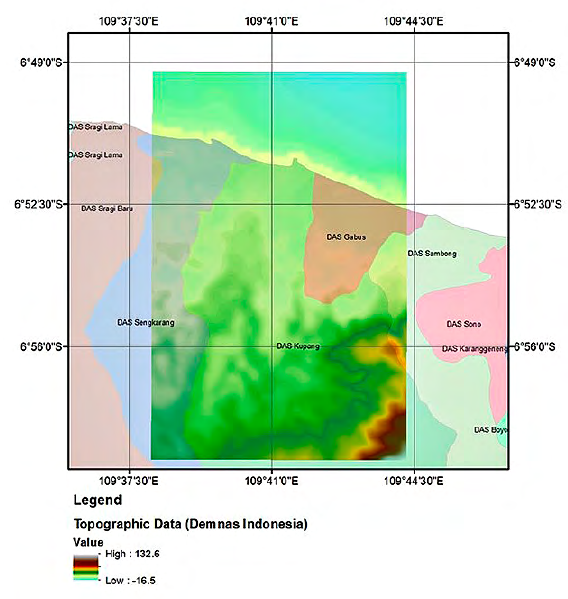
Figure 3. Topographic data Location Area